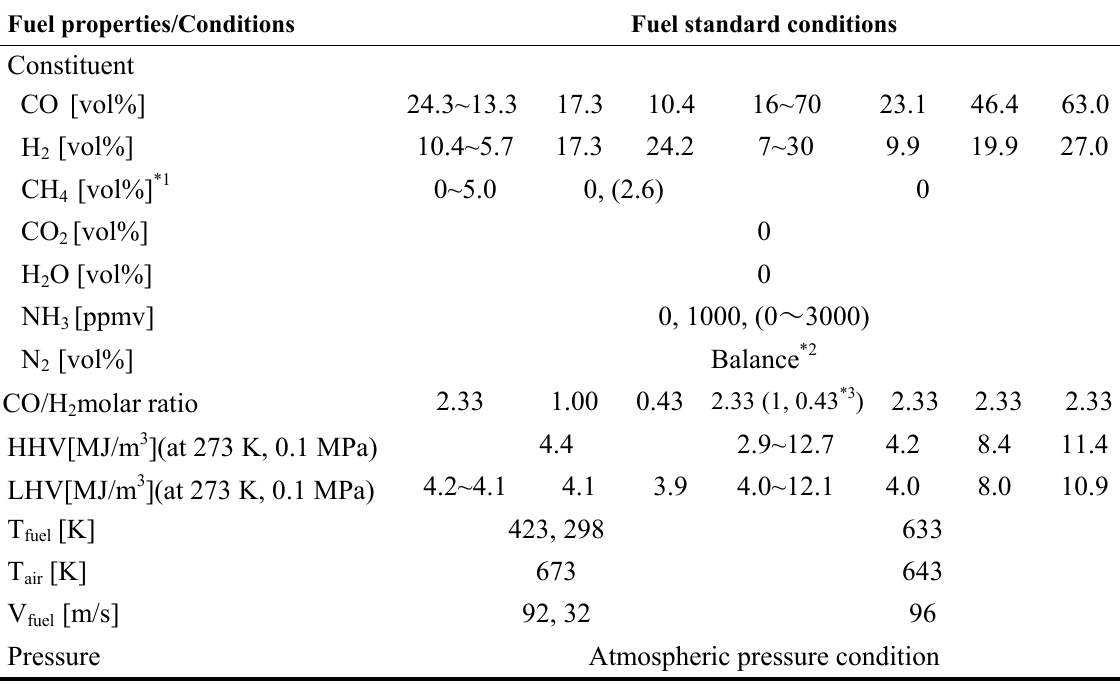
Table 4. Standard test conditions and supplied